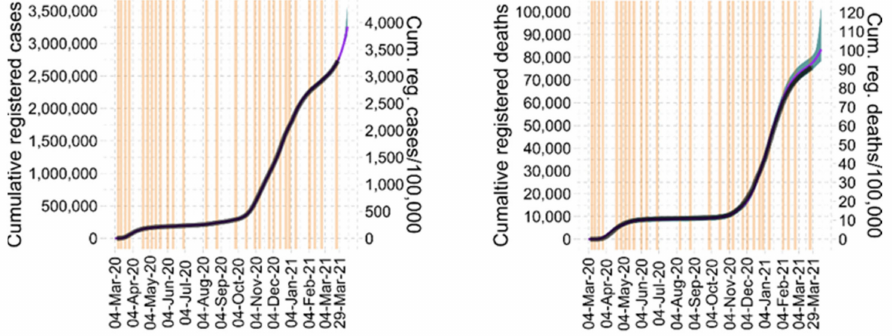
Figure 3. Agreement of model and cumulative data. We show cumulative infections and deaths dur- ing the course of the epidemic in Germany in between 4 March 2020 and 29 March 2021. Comparison of IO-NLDS model (magenta curve) and data (solid black curve) is provided. A good agreement is observed (shaded area = prediction uncertainty, vertical lines = changes in NPIs/contact behavior).